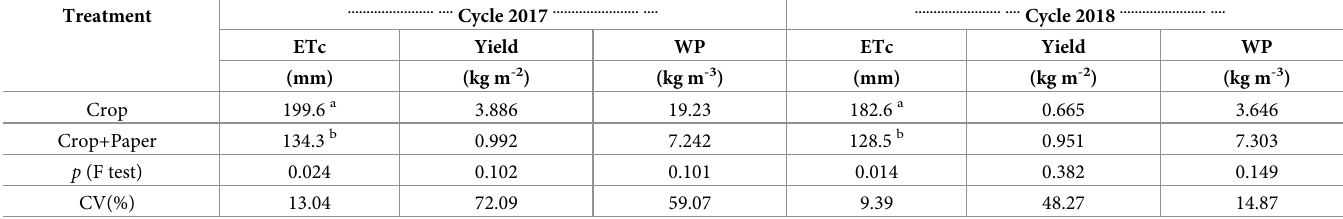
Table 2. Mean values of crop evapotranspiration (ETc), water productivity (WP) and fruit yield of Italian zucchini cultivated in the conventional system (Crop) and with recycled paper as mulch (Crop+Paper). Vic¸osa-MG, DEA-UFV, 2017–2018.